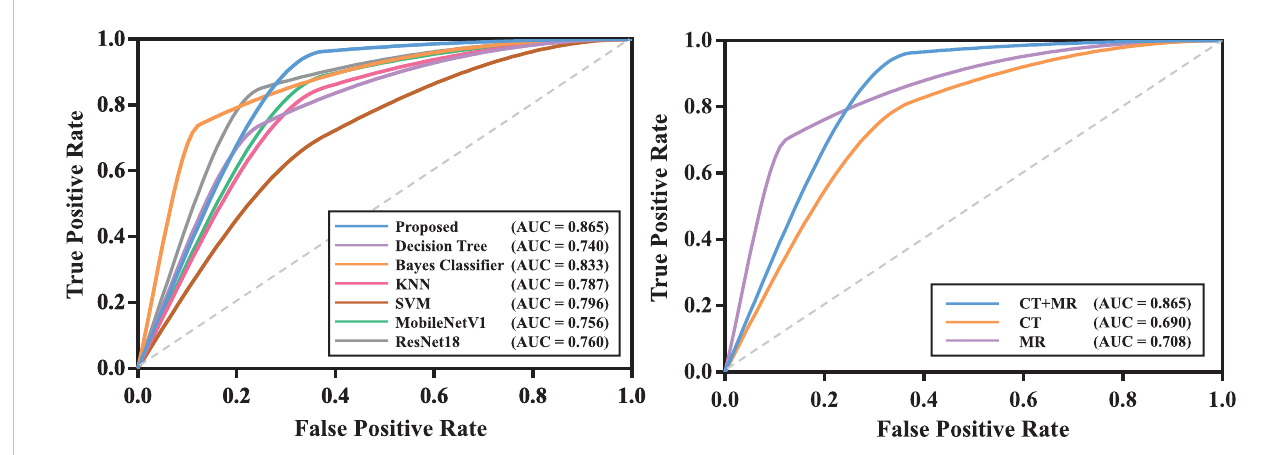
FIGURE 5 The ROC curves of models in testing cohort. The model with the best test result was shown. Left: ROC curves of all competing methods; Right: ROC curves of the proposed model with mono-modality and multi-modality